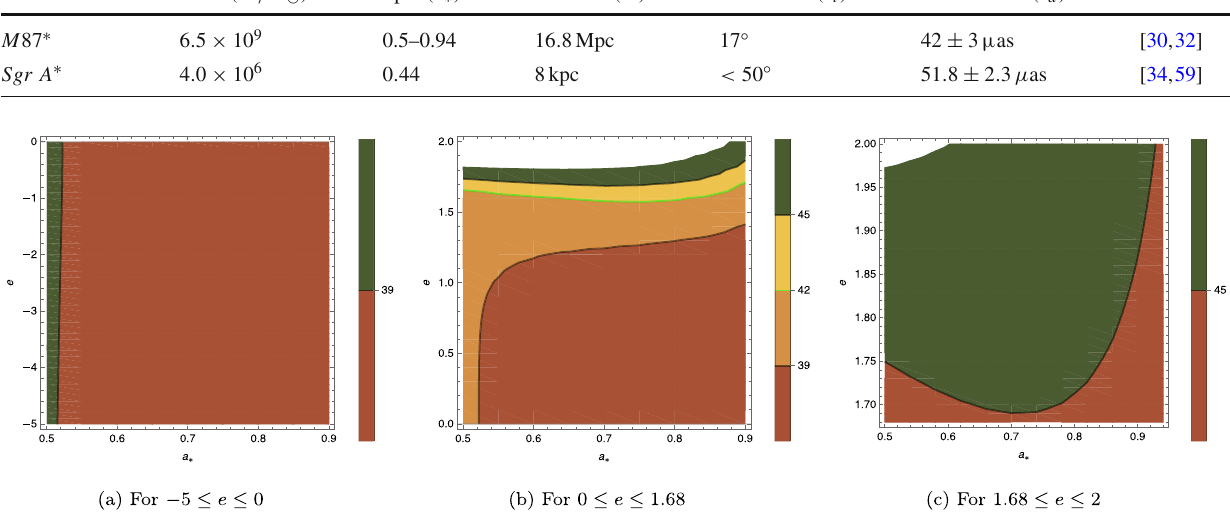
Fig. 4 Contour plots for angular size of M 87 ∗ shadow if modelled by the metric in Eq. (1). Values of a ∗ ∈ [ 0 . 5 , 0 . 94 ] , and e ∈ ( − 5 , 2 ) for which the shadow size is less than 39 μ as or greater than 45 μ as are disallowed. Values of b do not effect the shadow